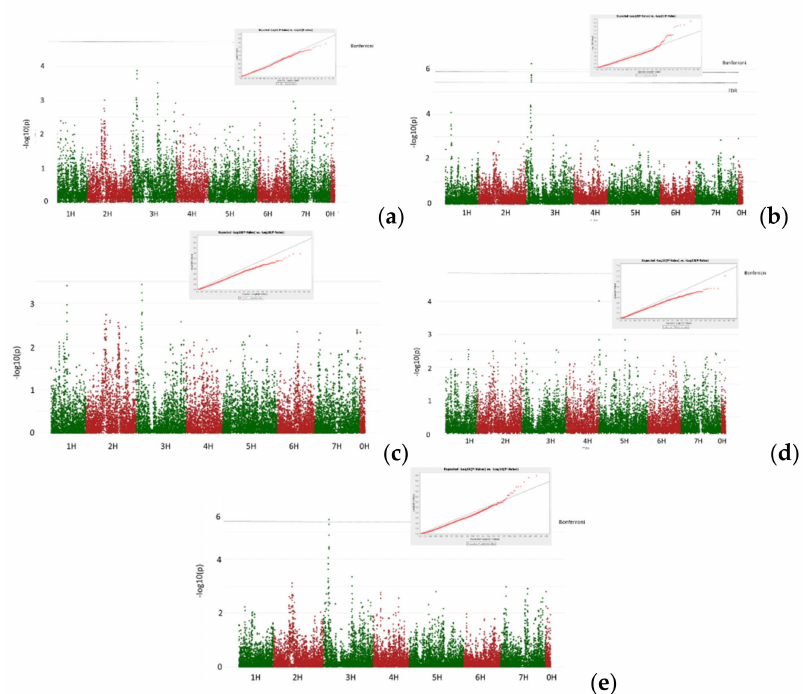
Figure A4. Manhatten plot for MLM + K model with QQ plot: ( a ) O18.2 seedling, ( b ) Ch3 seedling, ( c ) Kh2 seedling, ( d ) Ch3 adult, ( e ) first